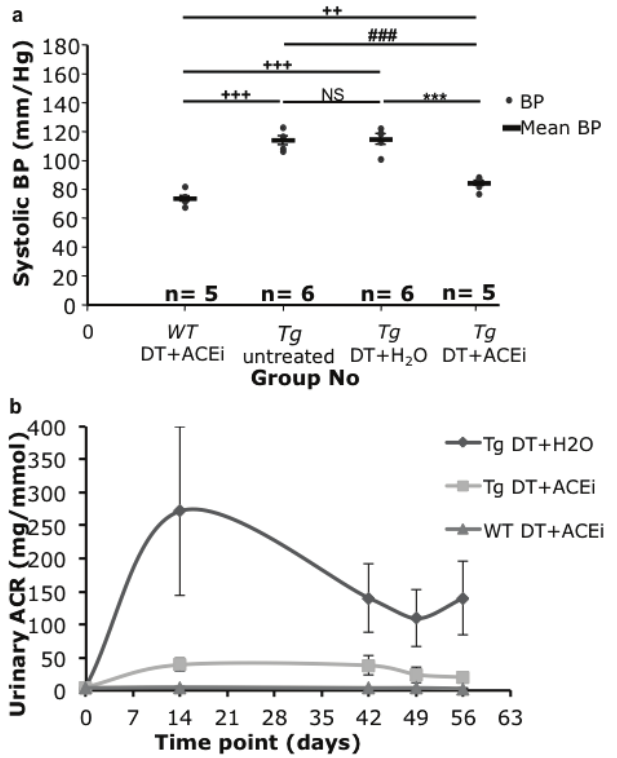
Figure 5. ( a ) Tail cuff blood pressure (BP) of Podo-DTR line 57 mice. At 7 weeks post DT injection (1ng/g bw), the BP of ACEi treated